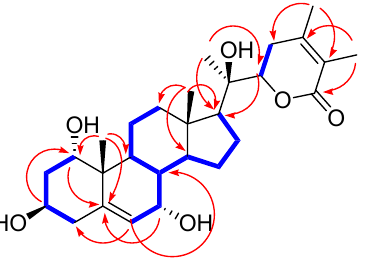
Figure 5. Key 1 H- 1 H COSY ( ) and HMBC ( ) correlations for 1a .